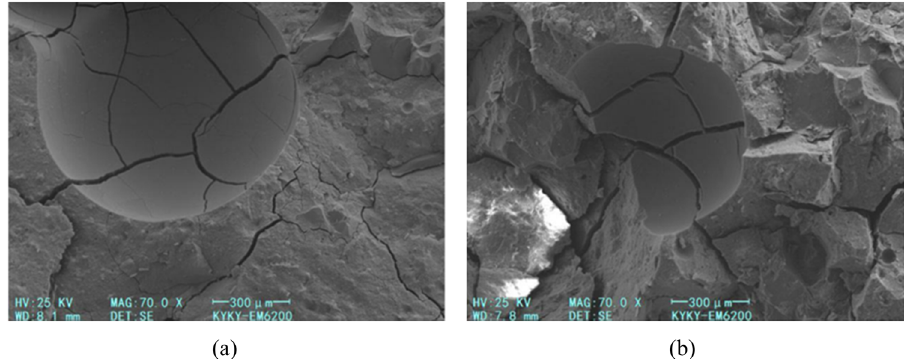
Figure 12: Micrographs of geopolymer without nano - SiO 2 to di ff erent temperature phases [ 92 ] . ( a ) 200°C:Si - 0 and ( b ) 400°C:Si -